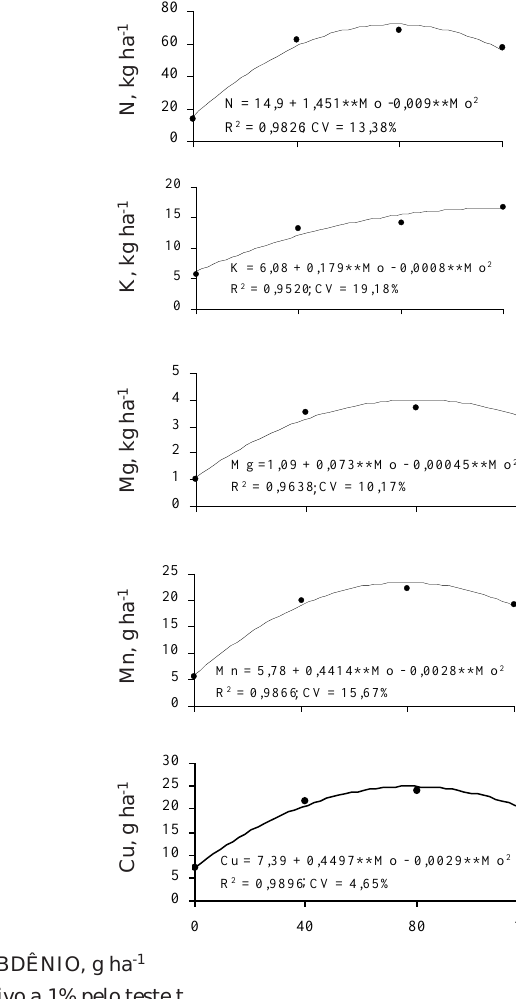
Figura 4. Nutrientes acumulados e exportados pelos grãos do feijoeiro cv. Ouro Negro, cultivado no outono- inverno de 1996, em função da adubação foliar com